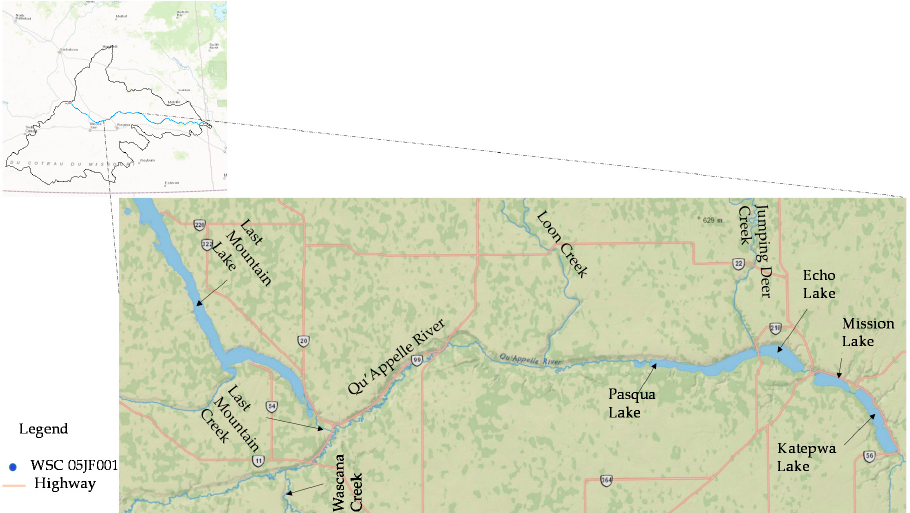
Figure 1. Map of the Qu’Appelle River System.